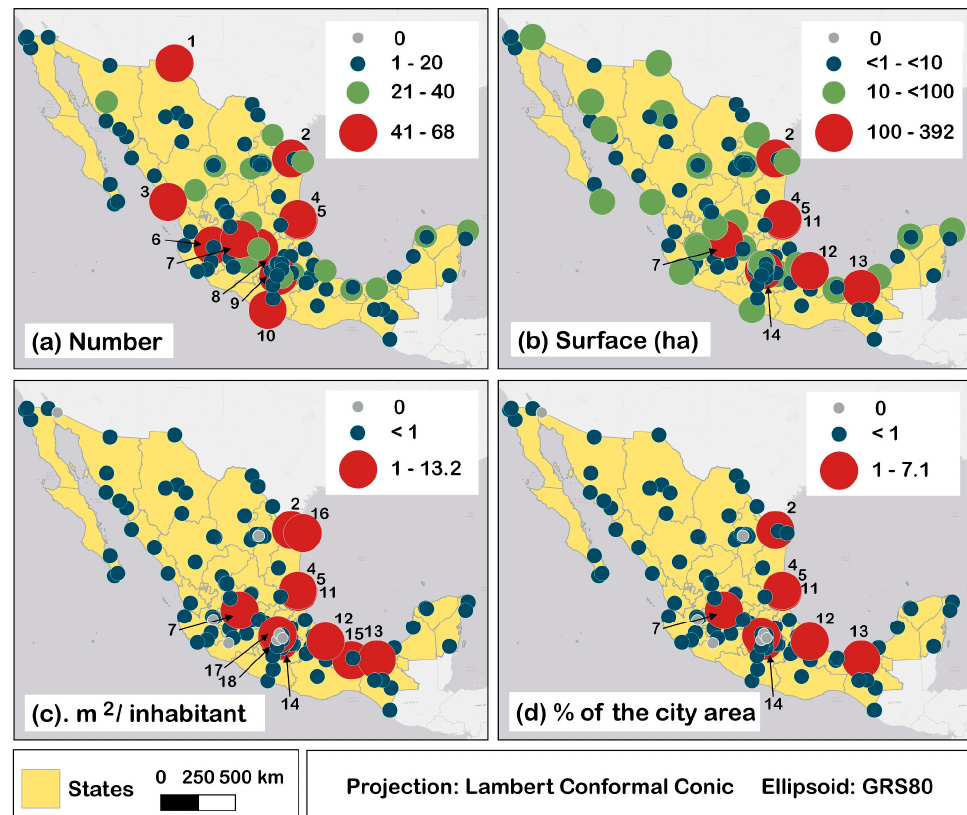
Figure 5. Lacustrine blue spaces indicators distribution in Mexico. ( a ) Number of blue spaces, ( b ) surface of blue spaces in hectares, ( c ) surface of blue spaces per inhabitant in m 2 , and ( d ) percentage that blue spaces cover of the city area. 1. Juárez, Chihuahua; 2. Reynosa, Tamaulipas; 3. Mazatlán, Sinaloa; 4. Miramar, Tamaulipas; 5. Ciudad Madero, Tamaulipas; 6. Zapopan, Jalisco; 7. León, Guanajuato; 8. Querétaro, Querétaro; 9. Jiutepec, Morelos; 10. Acapulco, Guerrero; 11. Tampico, Tamaulipas; 12. Veracruz, Veracruz; 13. Villahermosa, Tabasco; 14. Xochimilco, Mexico City; 15. Minatitlán, Veracruz; 16. Heroica Matamoros, Tamaulipas; 17. Cuautitlán Izcalli, Mexico City; 18. Ciudad López Mateos, Mexico City.